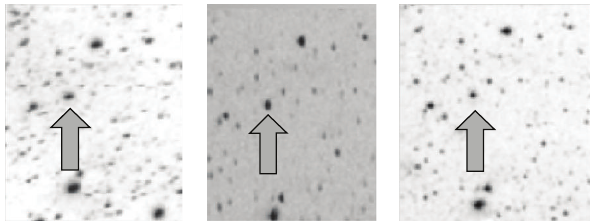
Figure 5: IGR J11215-5952 High-Mass X-ray Binary detected in gamma-rays by INTEGRAL and visible in optical light on historical F. A. plates (various